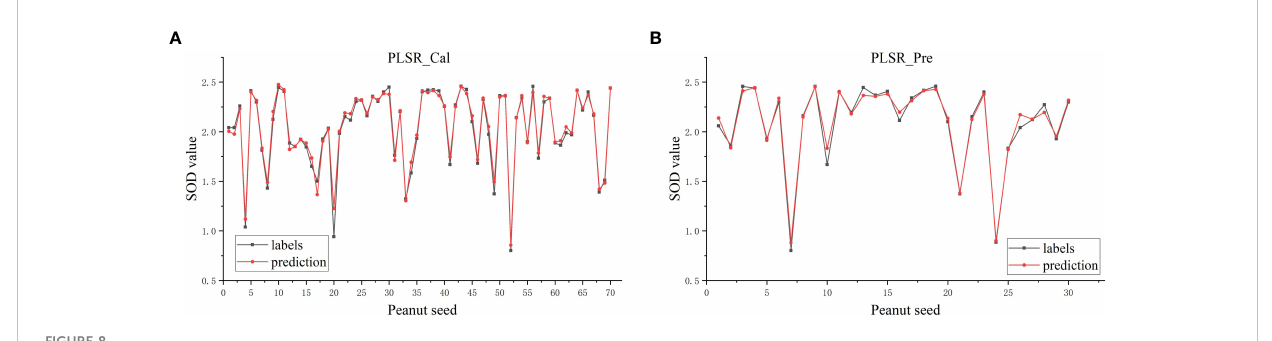
FIGURE 8 MSC- CatBoost-PLSR SOD activity prediction result graph: (A) Training set; (B) prediction